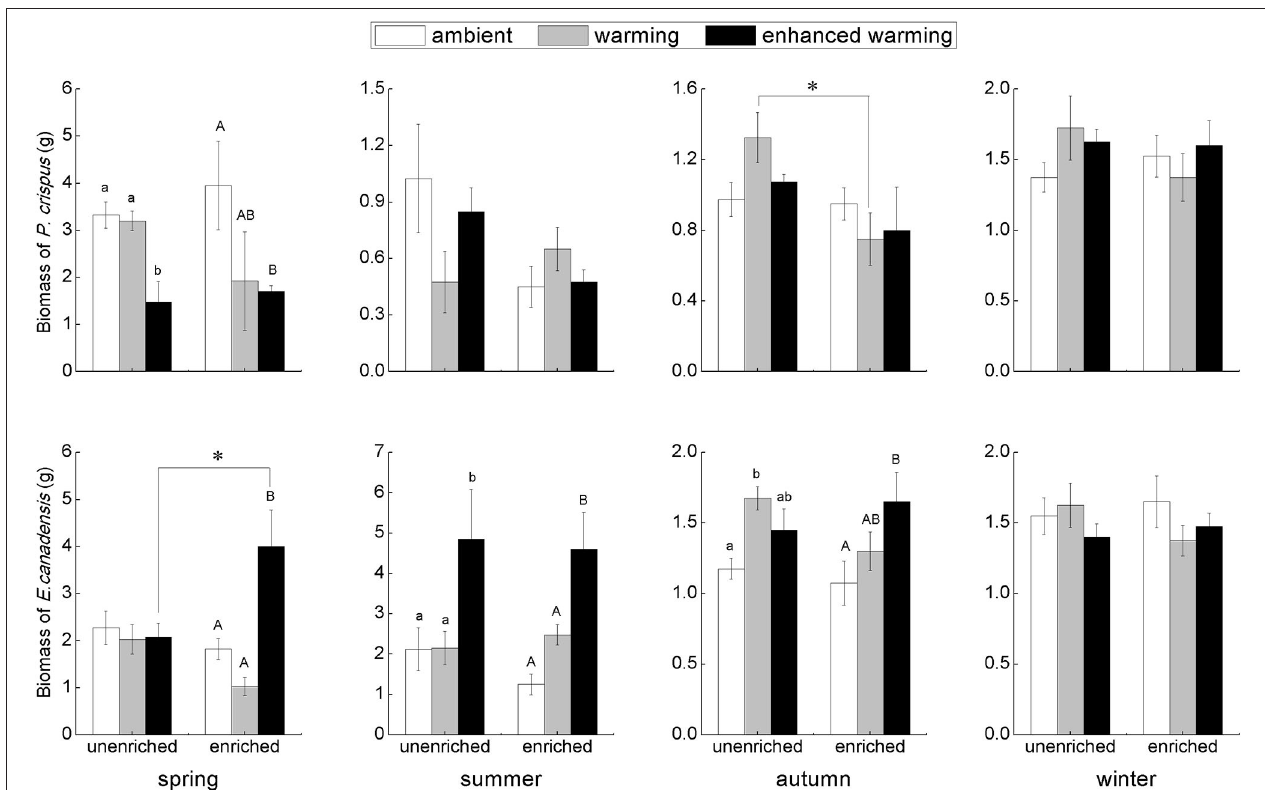
FIGURE 2 | The biomass (mean ± SE) of submerged macrophytes at different levels of temperature and nutrients in each season. Different letters indicate significant differences ( p < 0.05) among the three temperature scenarios. The asterisks above the bars indicate significant differences ( p < 0.05) between the two nutrient